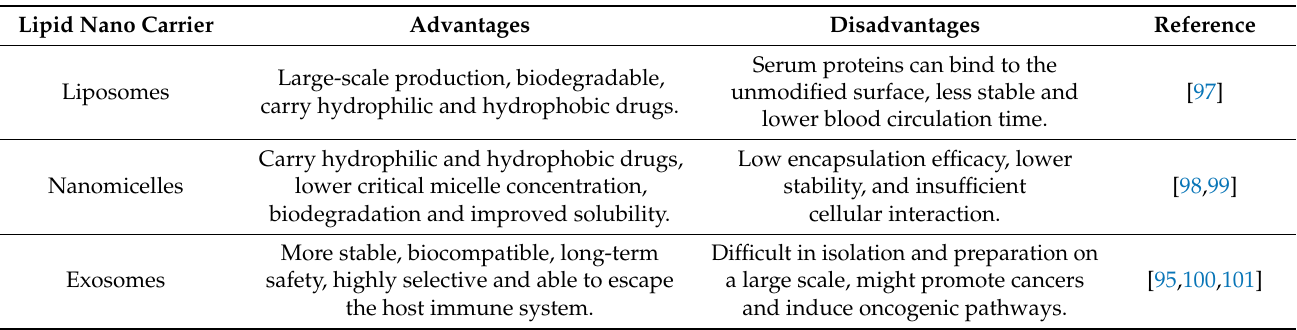
Table 2. The advantages and disadvantages of lipid nanosized vehicles and